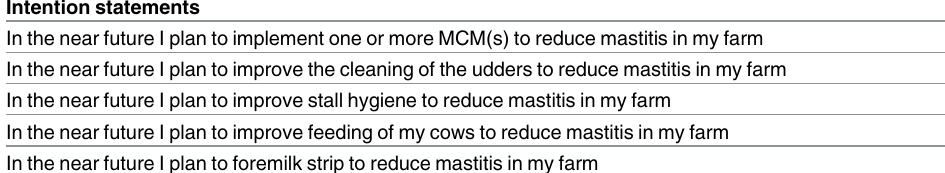
Table 1. Statements used in the face to face interviews to quantify farmers’intentions towards imple- menting non-specified mastitis control measuresand 4 specific mastitis control measures,using a 7 points bipolar Likert scale (-3 to